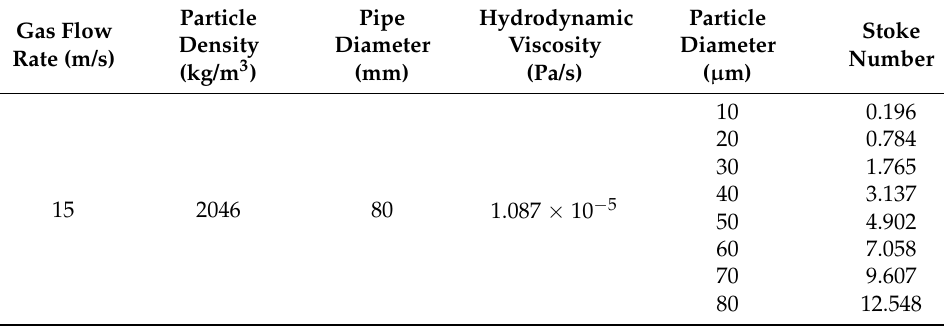
Table 6. Stoke numbers for different particle sizes.